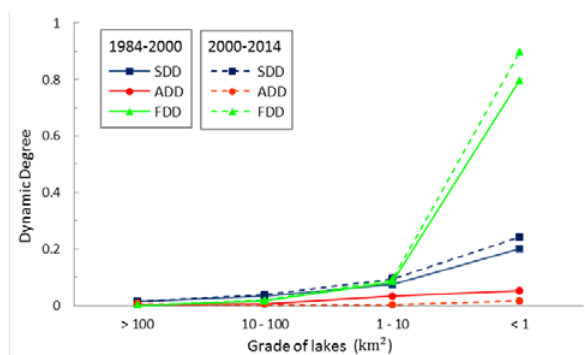
Figure 5. Comparison of dynamic degrees of lakes at all